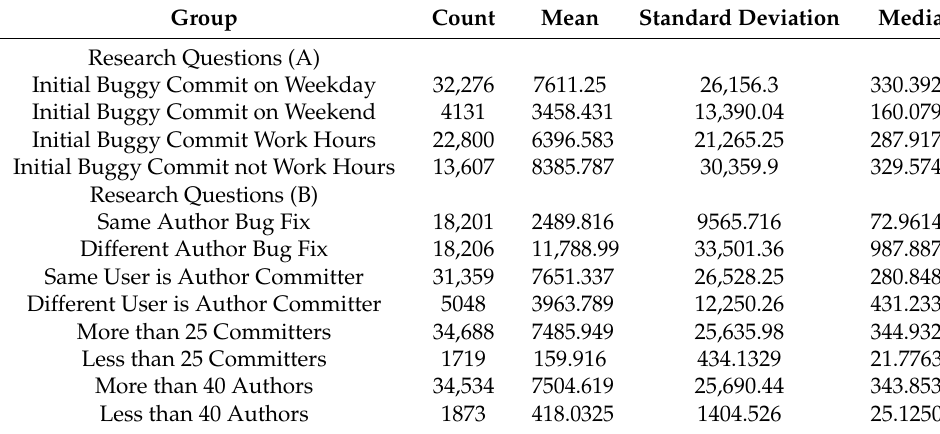
Table 1. Summary statistics per research question.